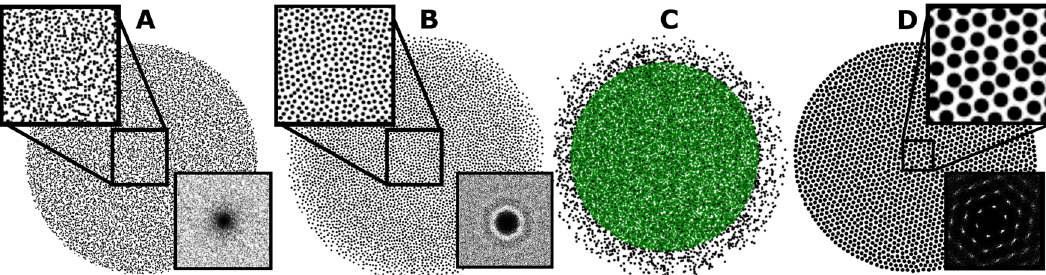
Fig. 1 Three different structural states of 2D vortices/rotors. ( A ) Hyperuniformity for Euler point vortices, ( B ) Hyperuniformity for QG rotors/surface rotors, ( C ) Phase enrichment induced by circulation differences where green (black) represents vortices of high (low) circulation, and ( D ) Crystallization arising from hydrosteric interactions. The insets of ( A ), ( B ), and ( C ) show the structure factor, S ( q ). In ( A ) and ( B ), S ( q ) decays to zero at small q , indicating that the distribution is hyperuniform. In ( C ), the structure factor shows the six distinct peaks of a hexagonal